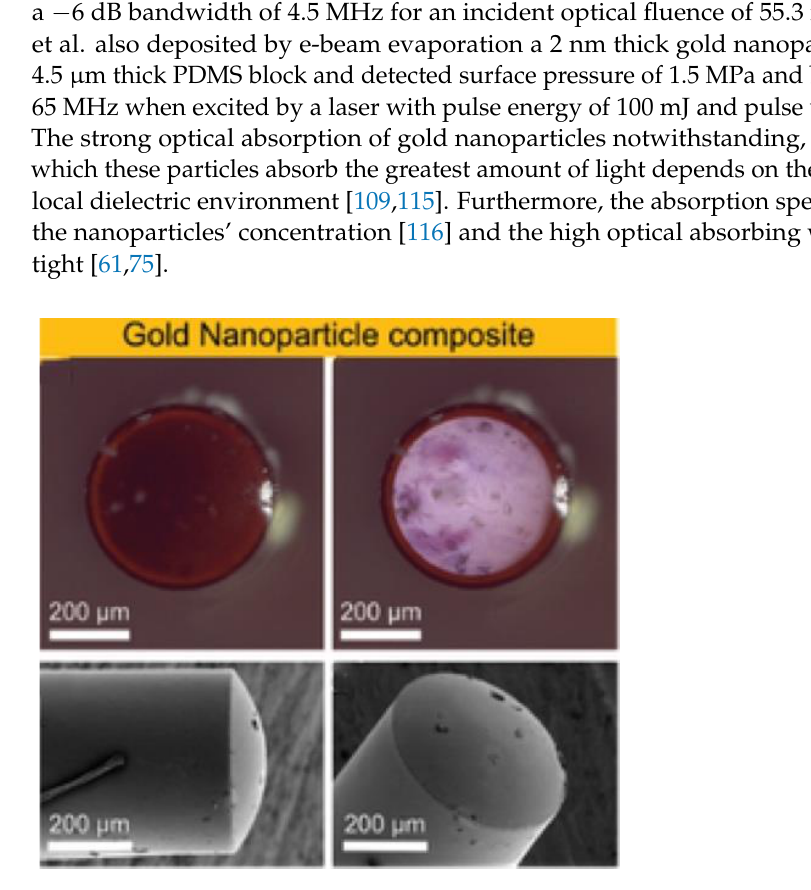
Figure 7. Images of the optical fiber’s distal end covered by gold nanoparticles-PDMS composite. Reproduced with permission from [61].